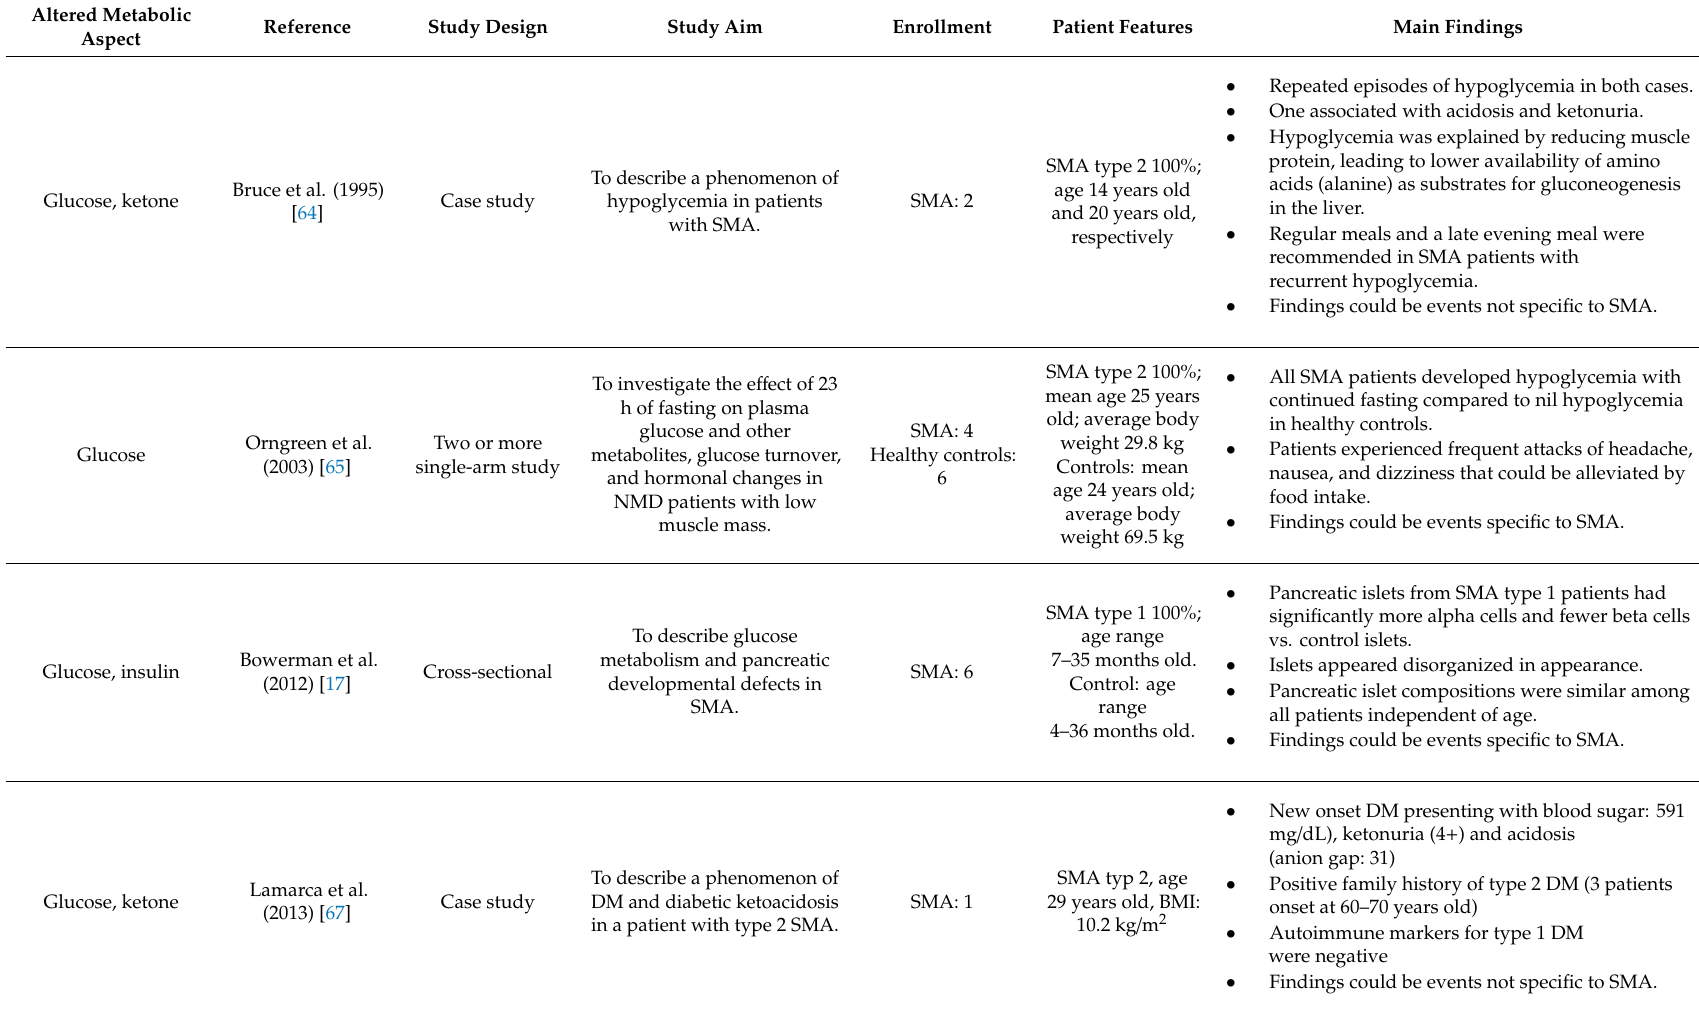
Table 2. Altered Glucose Metabolism in Patients with Spinal Muscular